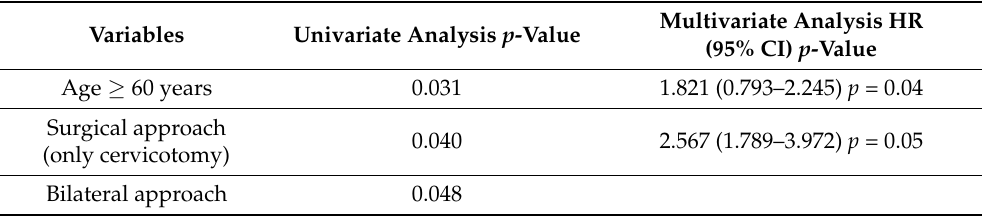
Table 2. Risk factors for post-operative complications at univariate and multivariate